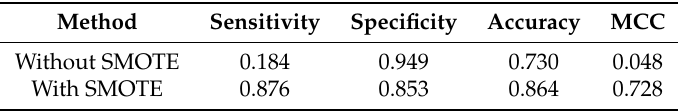
Table 4. Prediction results with and without SMOTE.